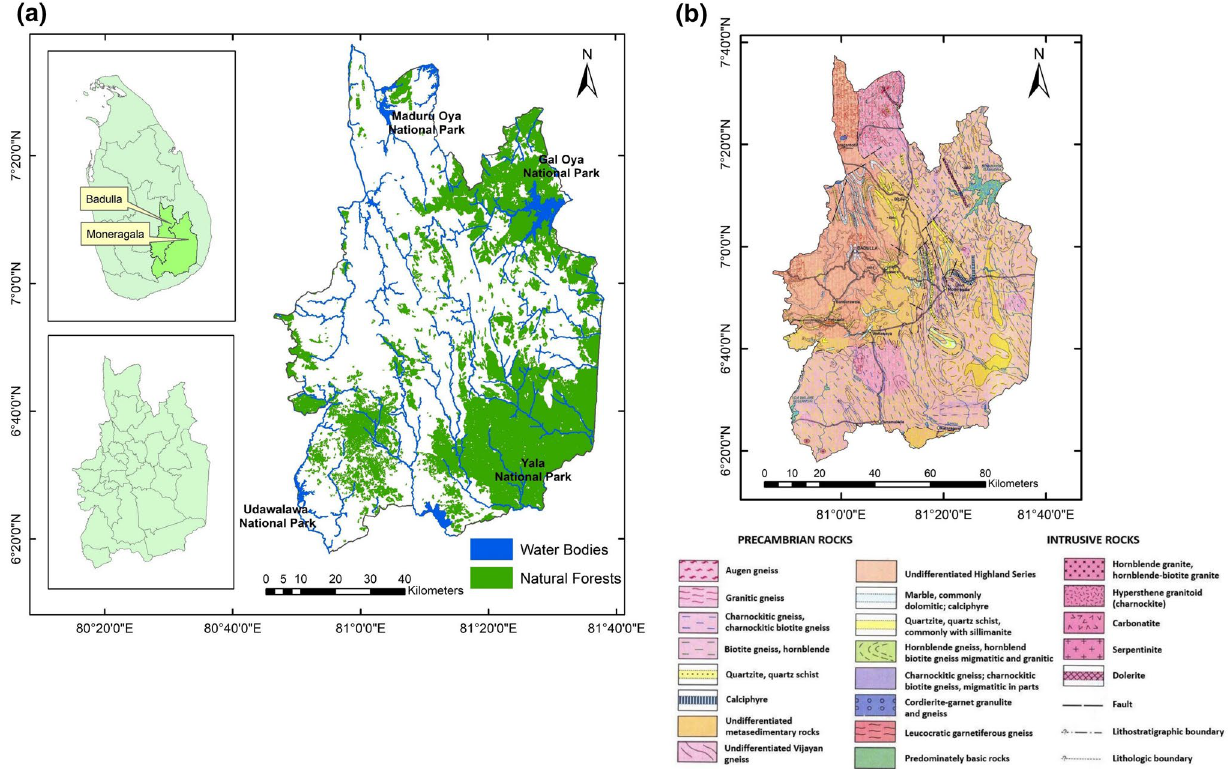
Fig. 1 a Hydrology and protected nature reserves of the UP b Geology map of the